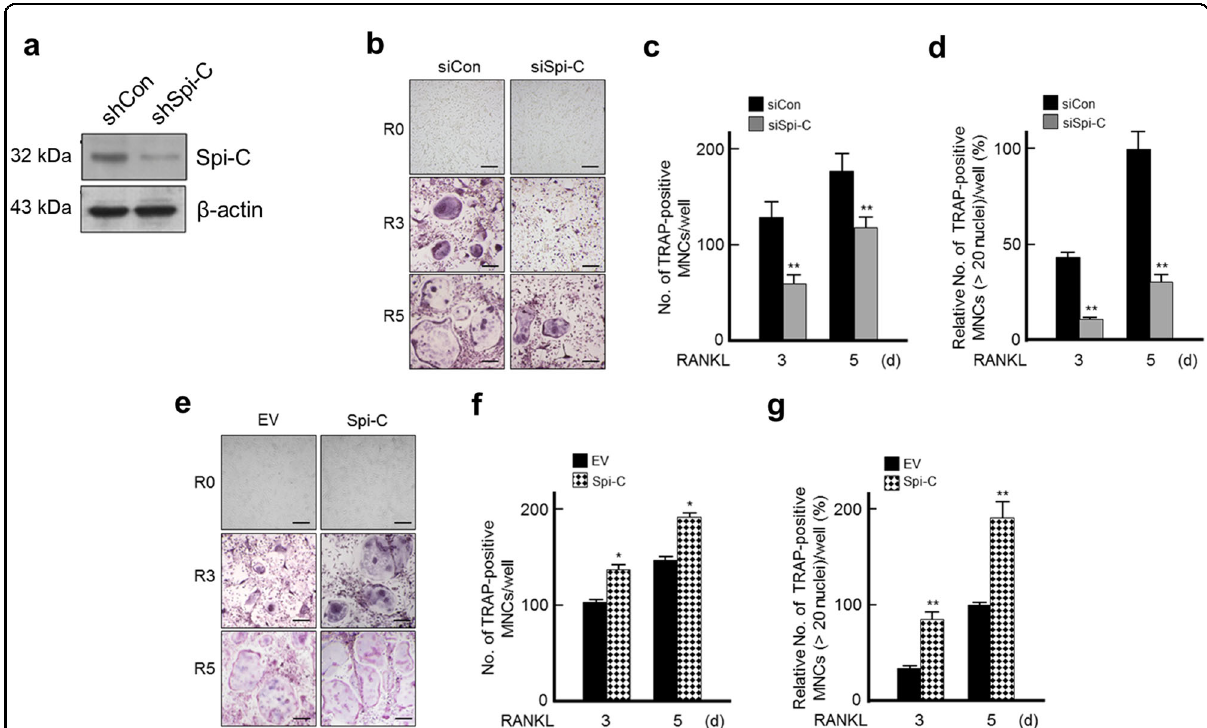
Fig. 2 Spi-C promoted RANKL-mediated osteoclast differentiation. a After transfecting BMMs with a scrambled nontargeting siRNA (siCon) or Spi-C siRNA (siSpi-C), the cells were incubated with RANKL (200 ng/ml) for 3 days. Then, the cells were lysed and subjected to western blot analysis with the indicated antibodies. b – d BMMs transfected with a scrambled nontargeting siRNA (siCon) or Spi-C siRNA (siSpi-C) were cultured with RANKL (200ng/ml) for the indicated times. TRAP staining was performed (original magni fi cation, ×100) b , and the number of TRAP + MNCs (>3 nuclei) c or large TRAP + MNCs with >20 nuclei d were counted and are presented as relative percentages (%). e – g BMMs infected with an empty lentiviral vector (EV) or a Spi-C-expressing lentiviral vector (Spi-C) were cultured with RANKL (200ng/ml) for the indicated times. Then, TRAP staining was performed as described in Fig. 2b. Scale bars, 100 μ m b , e . The data are presented as the mean ± SD of three independent experiments. * p < 0.05, ** p <